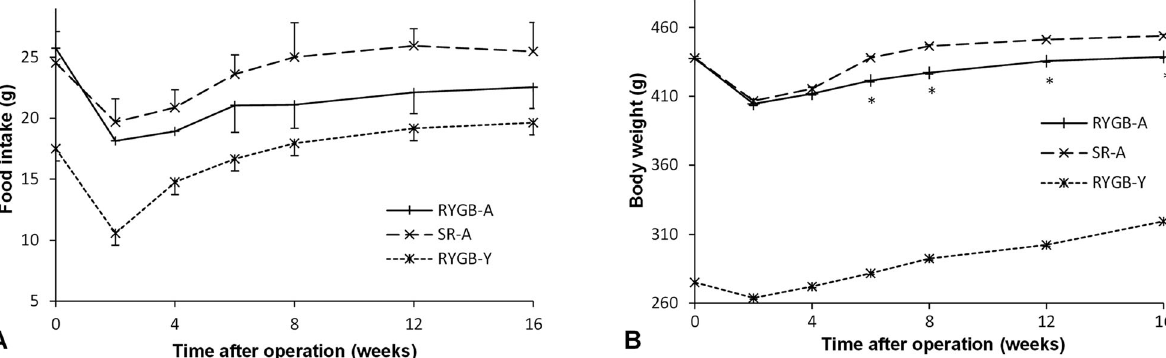
Fig. 2 The food intake and body weight curve of three groups. A The food intake curve of the RYGB-A group, the SR-A group and the RYGB- Y group. There was no signi fi cant difference in the food intake between the RYGB-A group and the SR-A group after surgery. B The body weight curve of the RYGB-A group, the SR-A group and the RYGB-Y group. The body weight of the RYGB-A group was signi fi cantly less than the SR-A group. The asterisk means signi fi cantly different compared to the SR-A group ( P < 0.05). RYGB-A, aged rat with Roux-en-Y gastric